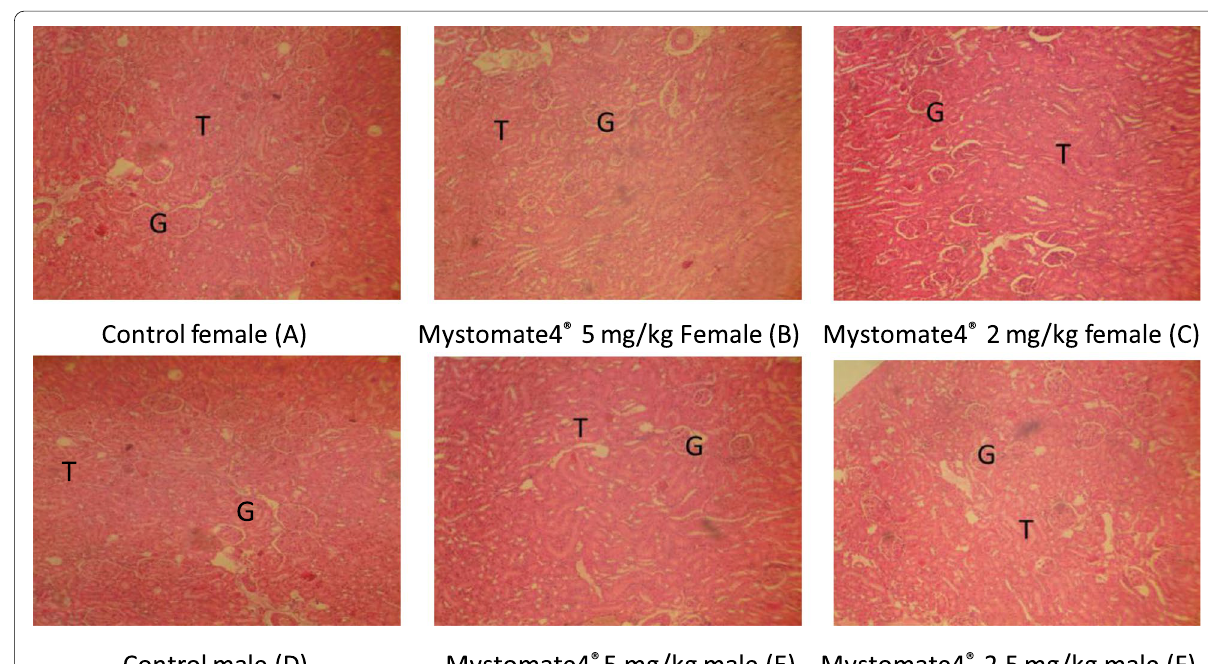
Fig. 3 Photomicrograph of the kidney tissue slides in control, 5 mg/kg-male, 5 mg/kg-female, 2.5 mg/kg-male and 2.5 mg/kg-female.